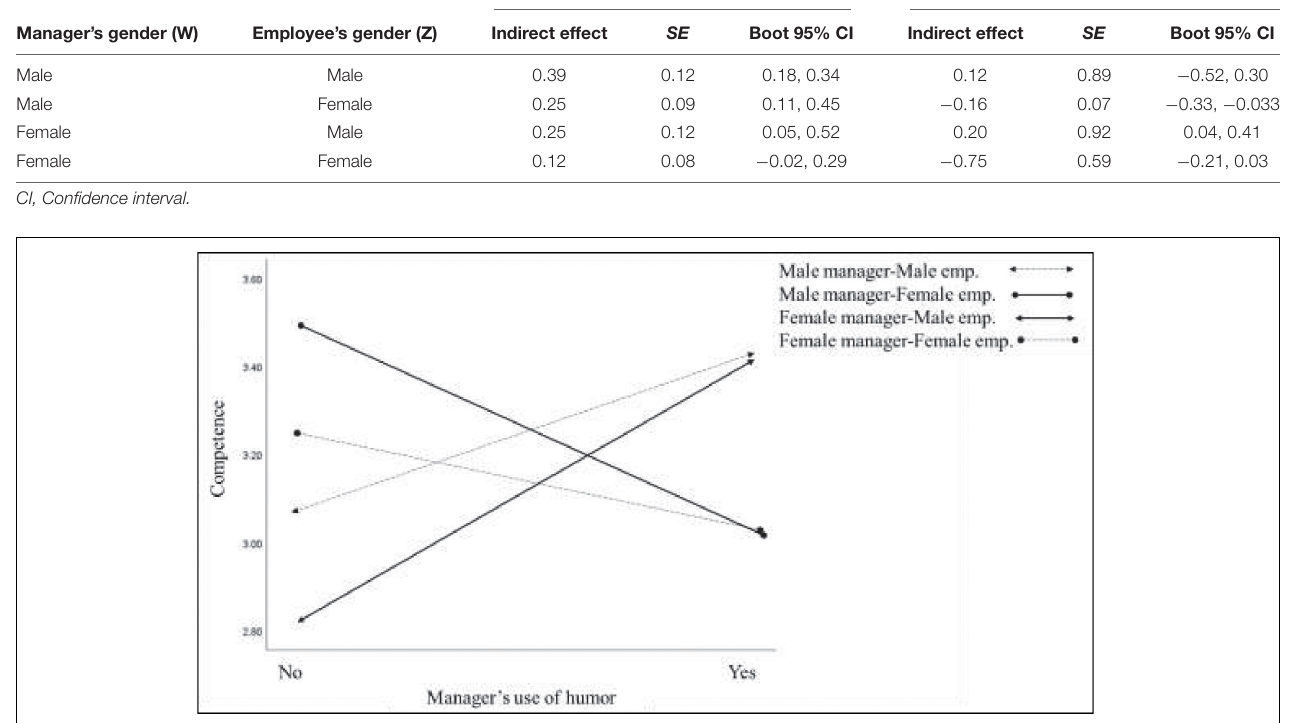
FIGURE 2 | The interaction between manager’s use of humor and gender, on employees’ perception of manager’s competence. emp, employee.